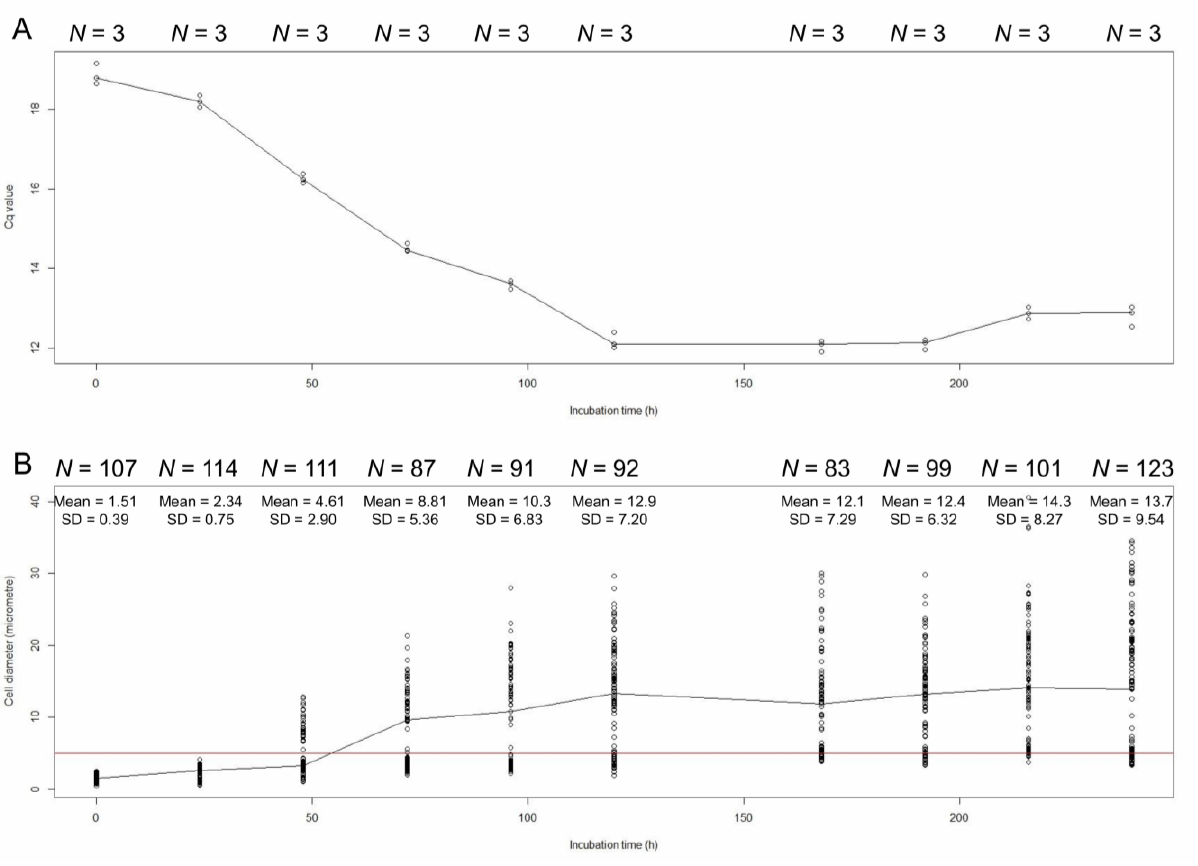
FIGURE 1: Cq values (A) and cell diameters (mm; B) of E. faecalis protoplasts at 0, 24, 48, 72, 96, 120, 168, 192, 216, and 240 h of incuba- tion. We used dnaA for qPCR. The red line indicates that the diameter of cells is 5